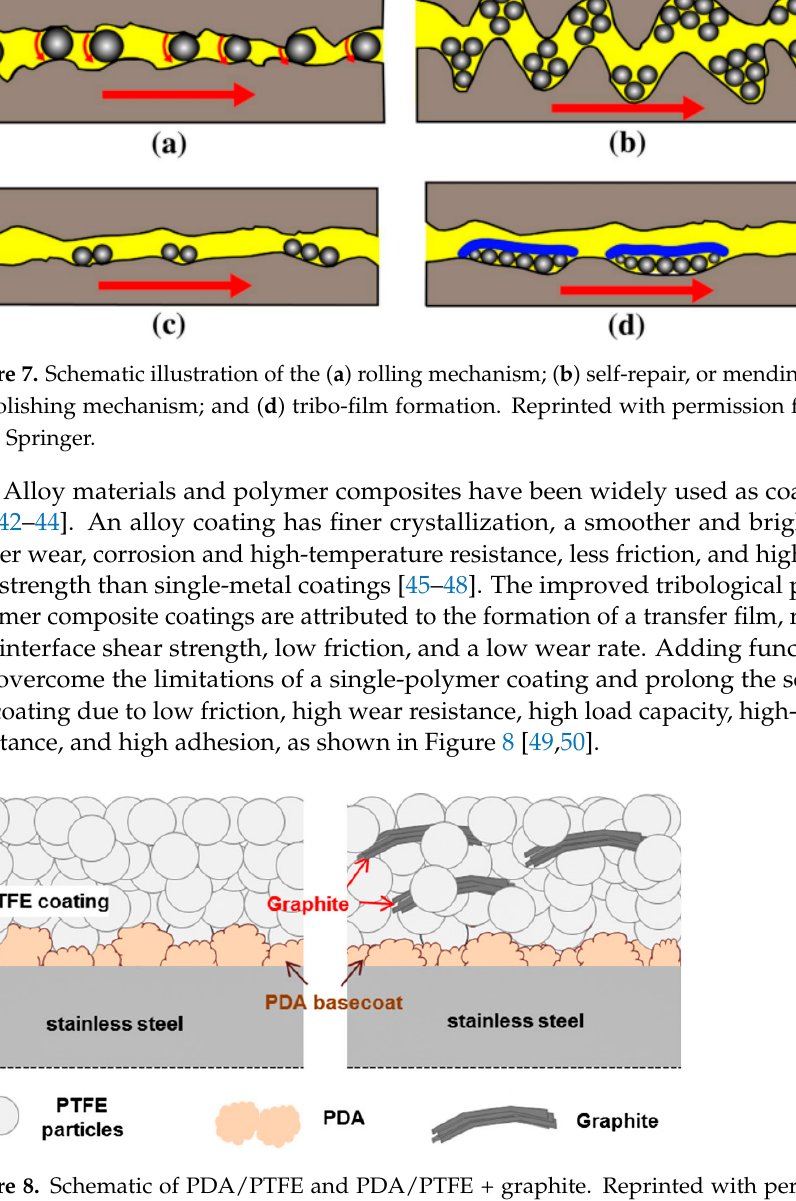
Figure 8. Schematic of PDA/PTFE and PDA/PTFE + graphite. Reprinted with permission from Ref. [49]. 2016, Springer.